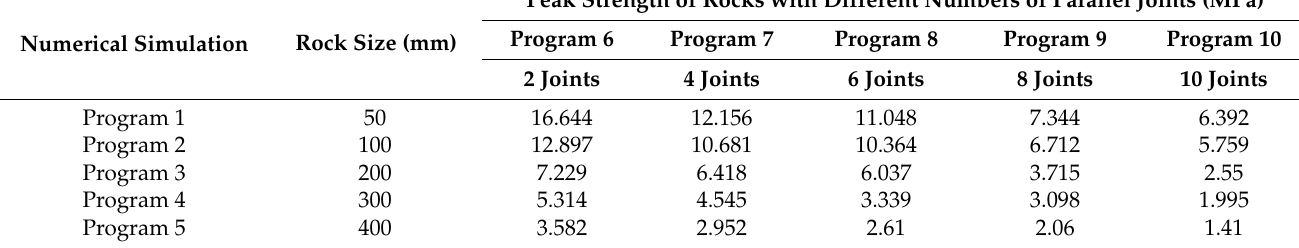
Table 5. Peak strength of rocks with different numbers of parallel